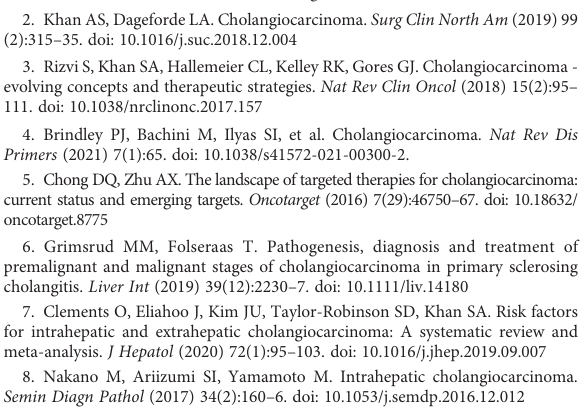
SUPPLEMENTARY FIGURE 1 Correlation analysis of DEGs expression in patients with CCA. SUPPLEMENTARY FIGURE 2 Immunohistochemical results of CTH, FGA, OTC and MMP11 of 10 CCA samples other than Figure